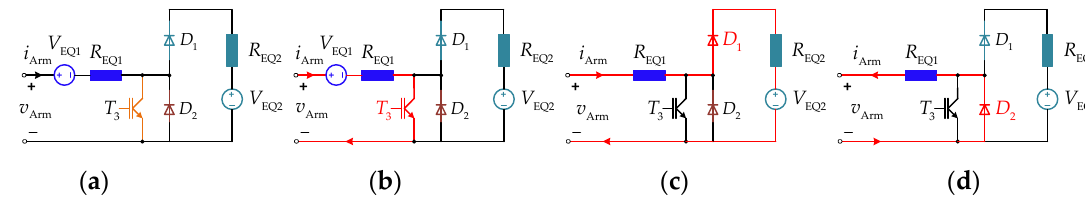
Table 1. The parameters of the equivalent circuit.